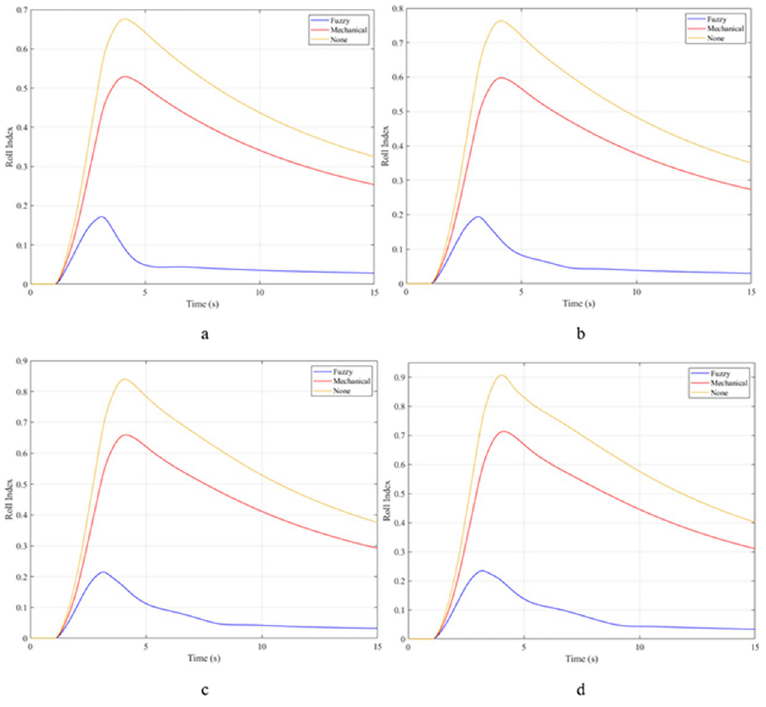
Fig 11. Roll index.